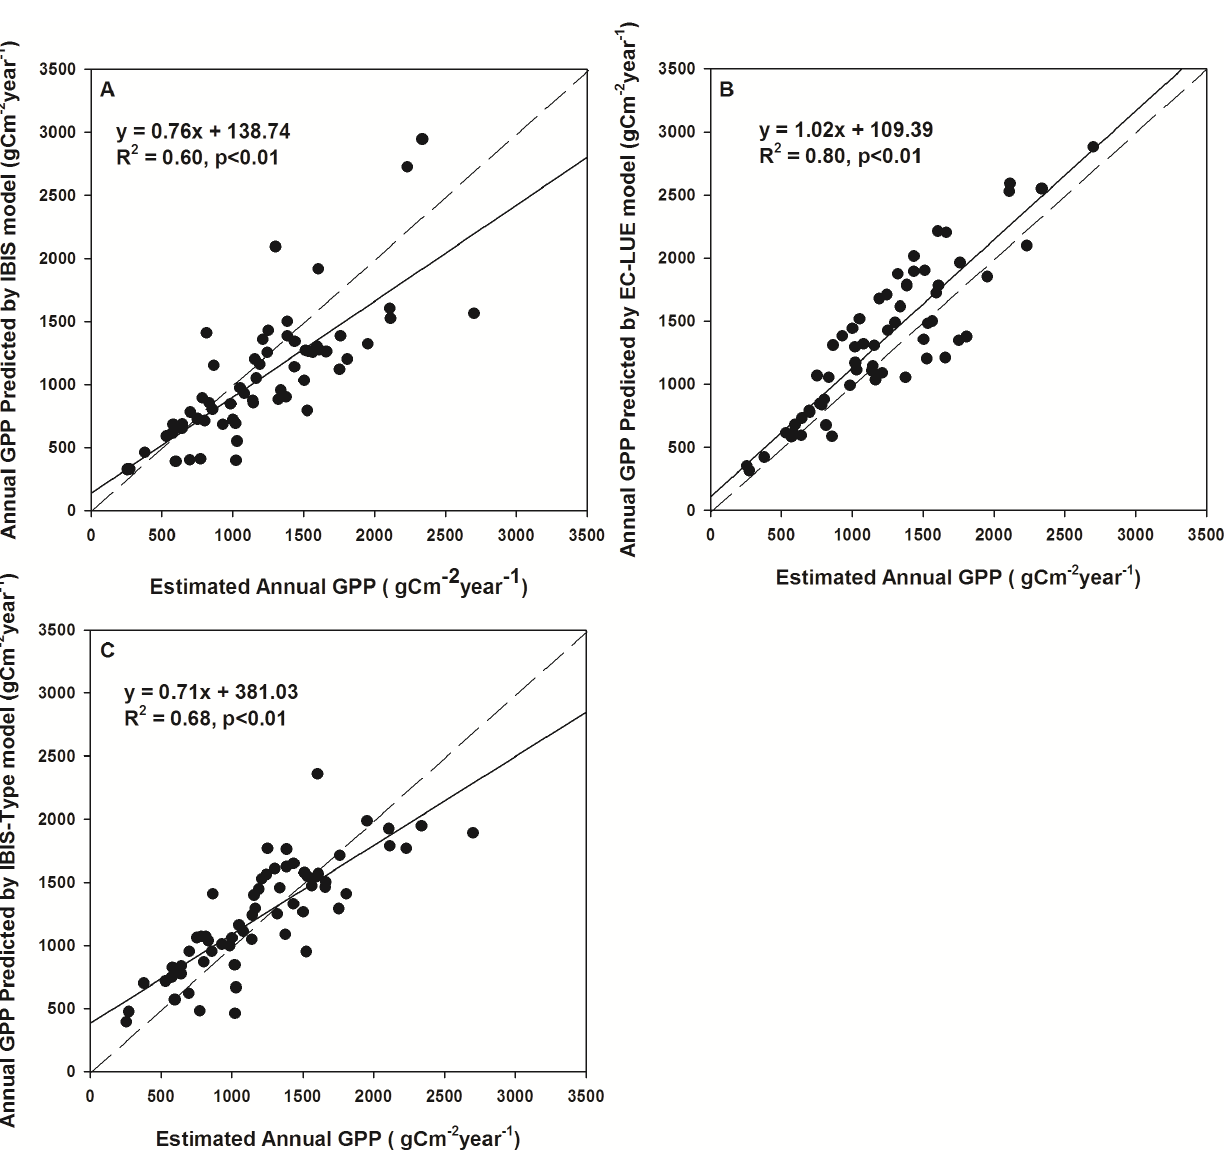
Figure 1. Comparison of predicted and measured GPP. Comparison between gross primary production (GPP) estimated from Eddy Covariance (EC) measurements and GPP predicted from different model simulations: (a) IBIS, (b) EC-LUE and (c) IBIS-Type. The solid lines are the linear regression lines and the short dashed lines are the 1:1 lines.